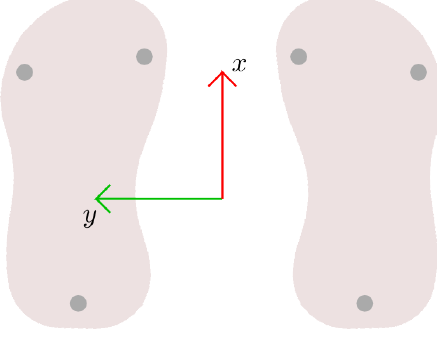
Figure 3. Feet shapes of the HeiCub robot. Three points are defined for contact modeling on each